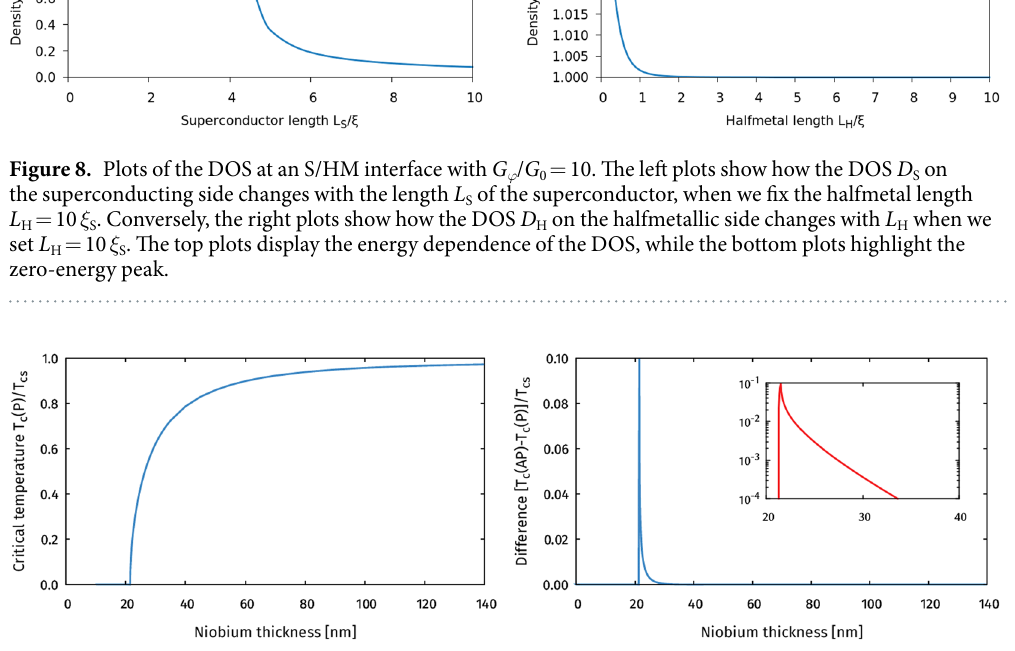
Figure 9. The left plot shows how the critical temperature in the parallel configuration T c (P) varies with the thickness of the superconductor. The right plot shows the critical temperature difference between the parallel and antiparallel configurations. The inset shows how this spin-valve effect decays on a logarithmic